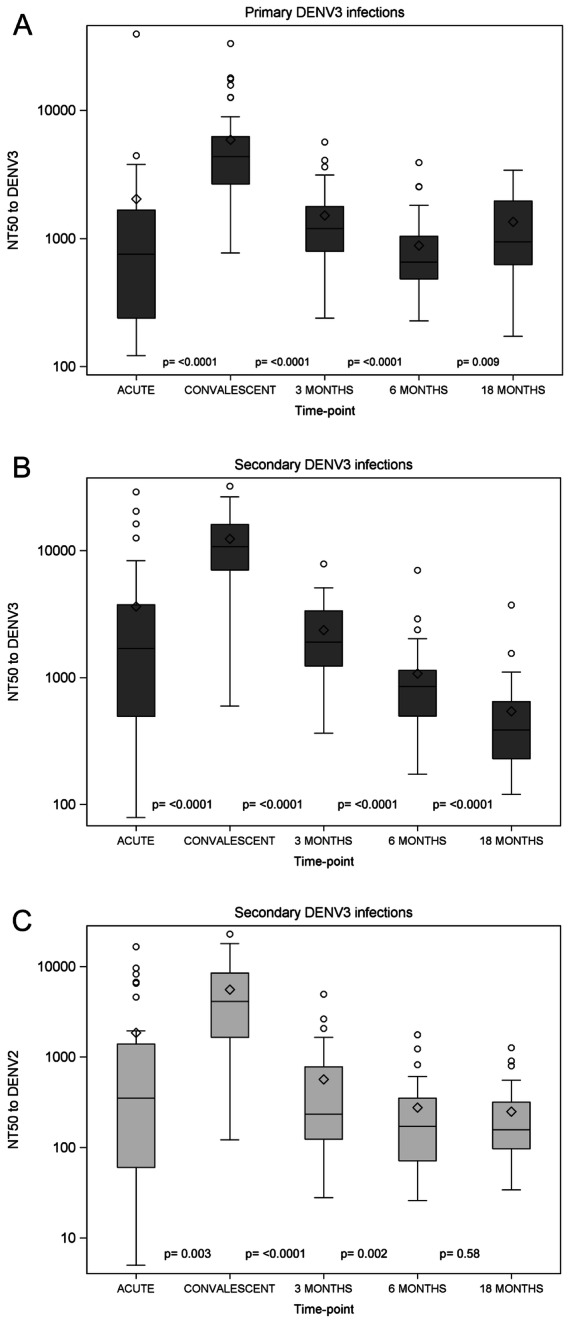
Longitudinal analysis of DENV-specific serum neutralizing Abs.
A. DENV3-specific NT50 of serum day 4–6 (acute), day 14–28 (convalescent), 3 m, 6 m and 18 m post-onset of symptoms in 1° DENV3 infections. Longitudinal serum samples were analyzed via a flow cytometry-based neutralization assay. The mean +/− SD as well as the 25th and 75th percentiles of NT50 are displayed. B. DENV3-specific NT50 of serum day 6 (acute), day 14–28 (convalescent), 3 m, 6 m and 18 m post-onset of symptoms in 2° DENV3 infections. Longitudinal serum samples were analyzed as described in Figure 1A. C. DENV2-specific NT50 of serum day 6 (acute), day 14–28 (convalescent), 3 m, 6 m and 18 m post-onset of symptoms in 2° DENV3 infections. Longitudinal serum samples were analyzed as described in Figure 1A. Diamonds, mean; middle line, median; upper and lower boundary of the box, intra-quartile range (IQR; 25th to 75th percentile); whiskers, range of values that are outside of the IQR but are close enough not to be considered outliers (within ≤1.5*IQR); empty circles: outliers >1.5*IQR.